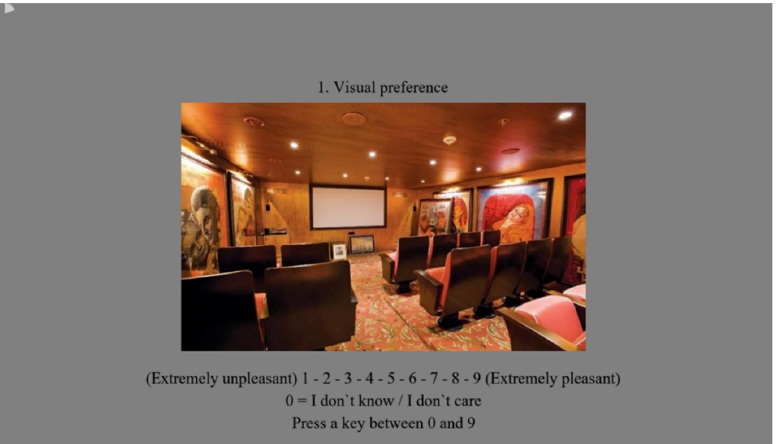
Figure 3. A 9 ‐ point Likert ‐ type scale was used to judge the visual preference, visual complexity, visual clarity, and colorfulness of images. The partial symbol on the left top corner indicated the progress.